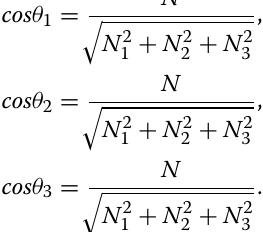
Fig. 10 Design of GFM scintillation